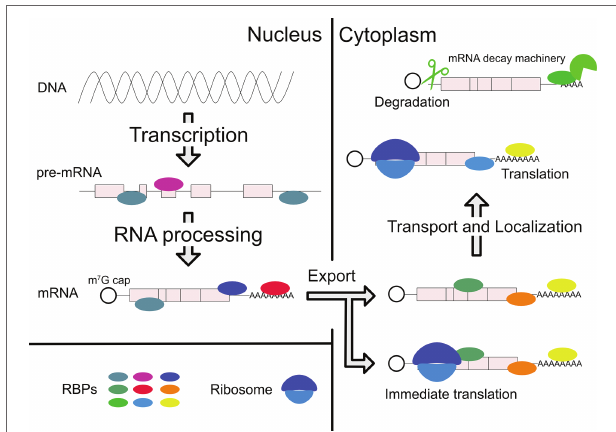
FIGURE 1 | Posttranscriptional regulations of gene expression by RBPs. After transcription, RBPs bind pre-mRNA and regulate RNA processing in the nucleus. Mature mRNA is transported to cytoplasm by other RBPs. In the cytoplasm, various RBPs control the different mRNA fates, which include localization, translation, and degradation. Collectively, these effects achieve proper gene expression within specific cell types and in response to specific biological regulatory signals. They can also lead to pathological conditions when regulation is compromised, for example, due to mutations in the gene encoding a specific